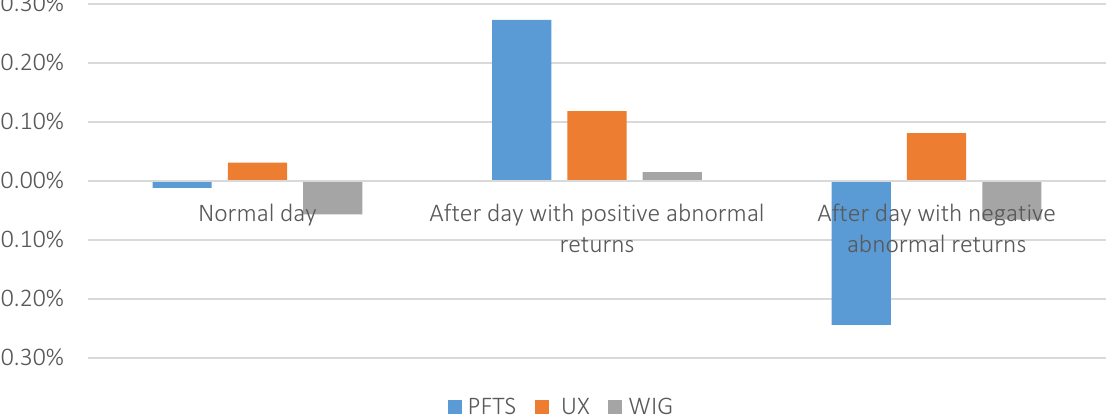
Figure 4. Average returns on usual days and on the days after the days with abnormal returns